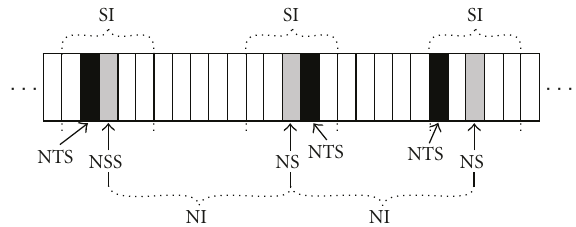
Figure 3: The frame structure for one node. The NSS and NSs are equally spaced with an interval of size NI. The SI parameter is also